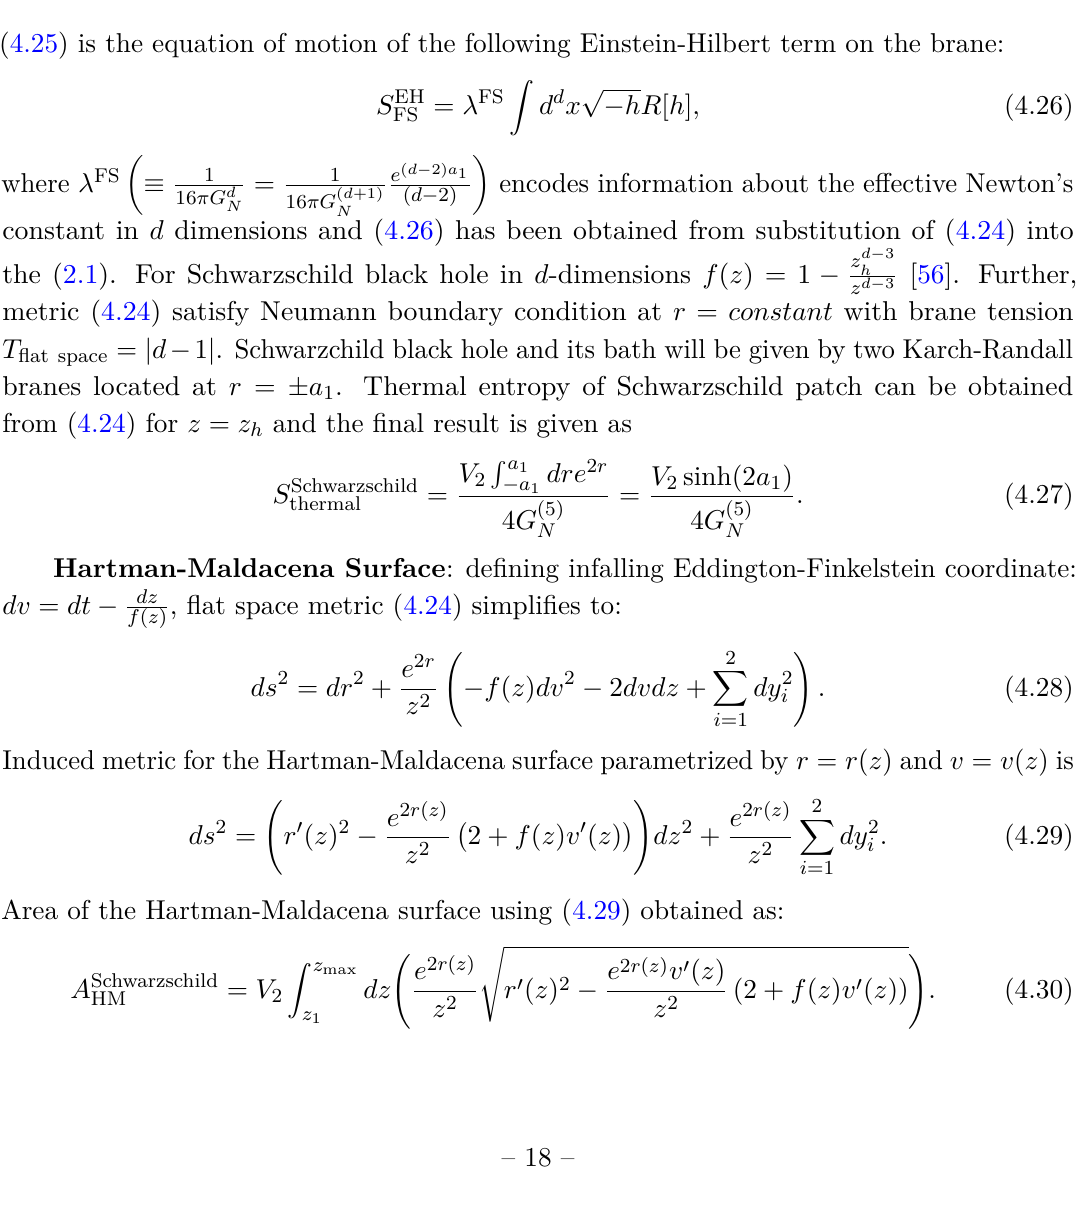
and Q are baths − s − 1